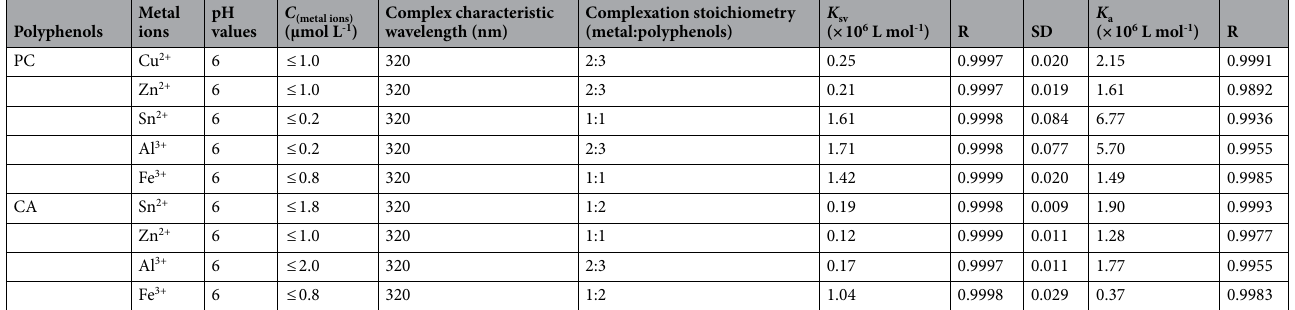
Table 2. Stern–Volmer quenching constants ( K sv) and the apparent binding affinities ( K a) for the interactions of PC and catechin (CA) with metal ions. R is the correlation coefficient. SD is the standard